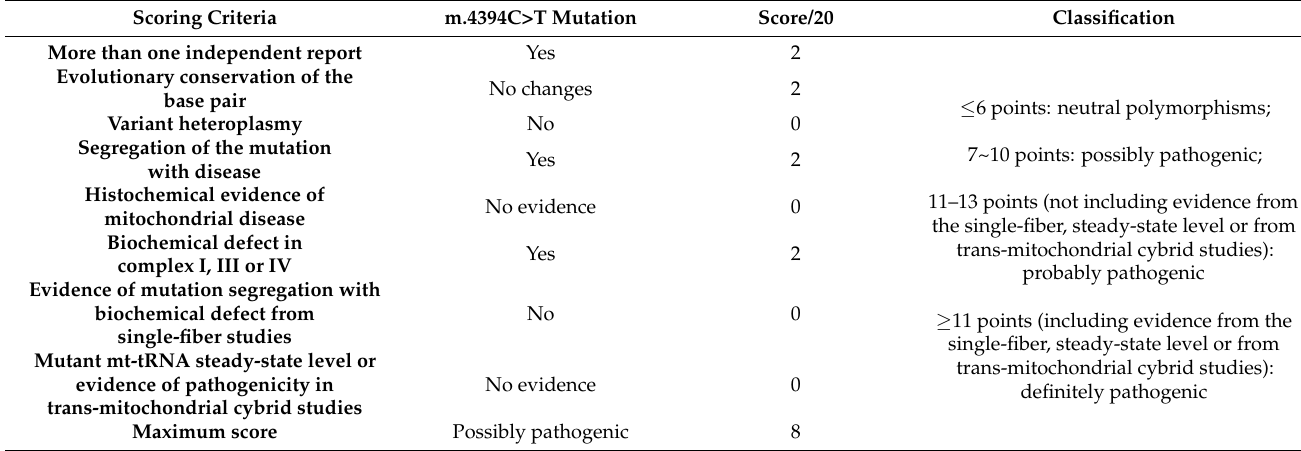
Table 4. The predicted pathogenicity of the mt-tRNA Gln 4394C>T mutation. Scoring Criteria